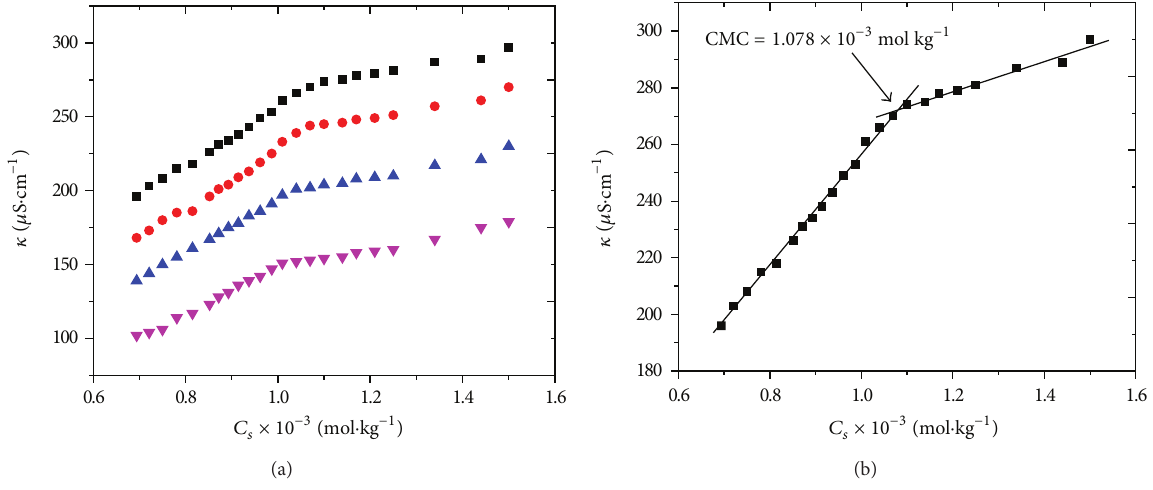
Figure 1: (a) Plots of electrical conductivity versus concentration of CTAB in presence of reactive orange 122 at 298 K (black square), 308 K (red circle), 318 K (blue triangle), and 328 K (purple triangle). (b) Plot of electrical conductivity versus concentration of CTAB in the presence of reactive orange 122 at 298 K. Table 1: The data of critical micelle concentrations (CMC), enthalpy of micellization ( Δ𝐻 ), free energy of micellization ( Δ𝐺 ), entropy of micellization( Δ𝑆 ),anddegreeofdissociation( 𝛽